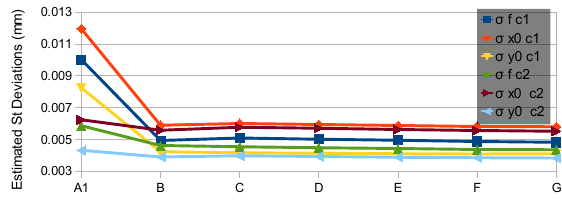
Figure 5. Estimated standard deviations of f, x 0 and y 0 for both cameras.